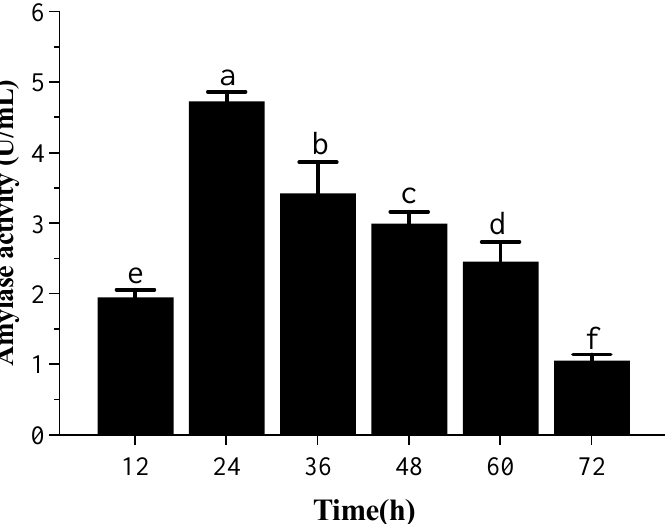
Figure 8. α -amylase activity by B. subtilis T5 with respect to different incubation periods; mean values with the different letters are significant ( p ≤ 0.05).